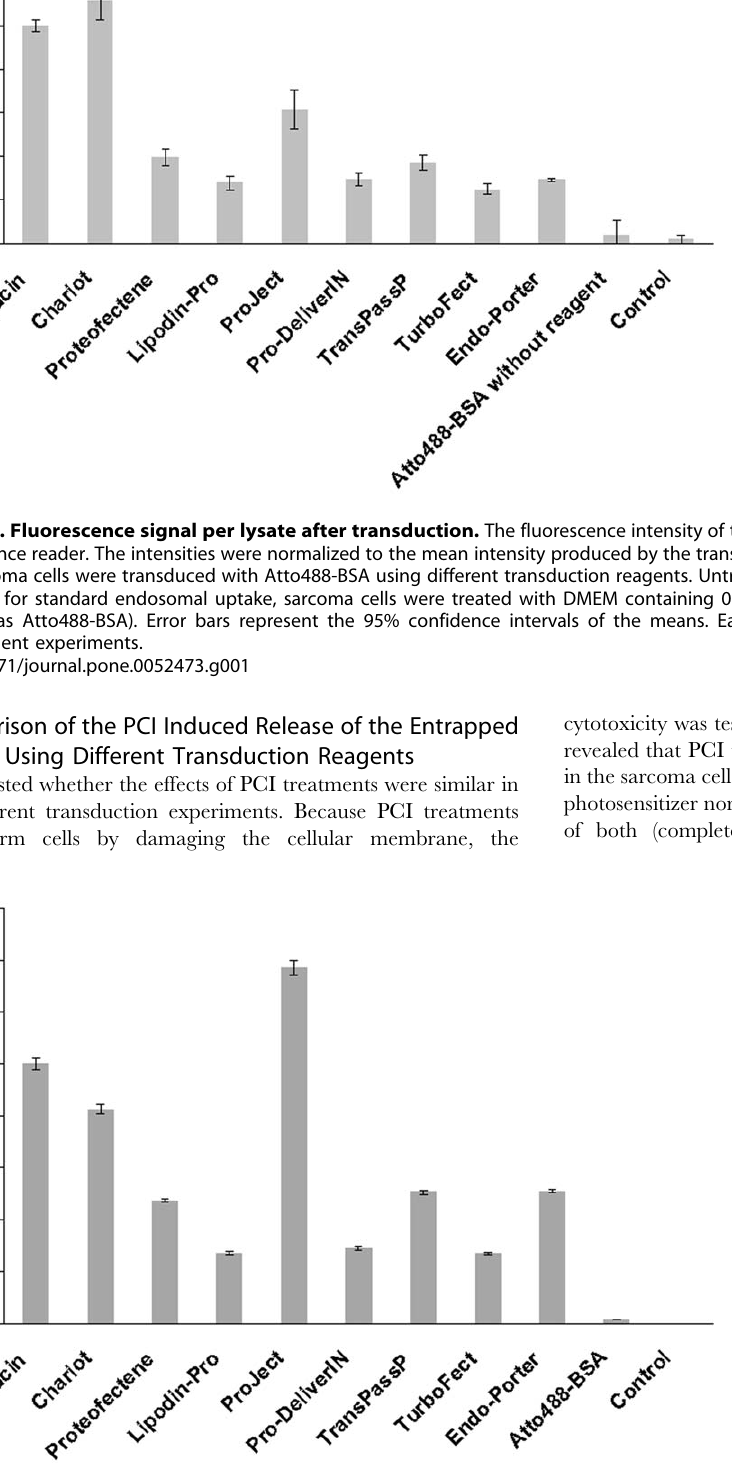
Figure 2. Fluorescence signal per cell after transduction. Sarcoma cells were transduced with Atto488-BSA using different transduction reagents. The fluorescence was measured in a flow cytometer, untreated cells were used as control and standard endocytosis was measured by treating the cells with 2 m g Atto488-BSA containing DMEM. Error bars represent the 95% confidence intervals of the means depicted. Measurements were set to 20000 gated events.